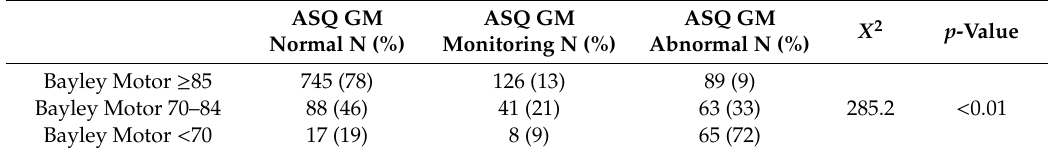
Table 2. Comparison of Bayley-III Motor Composite and ASQ Gross Motor (GM).